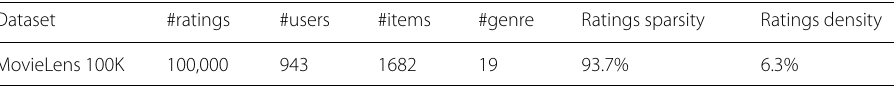
Table 5 The statistics of ml-100K